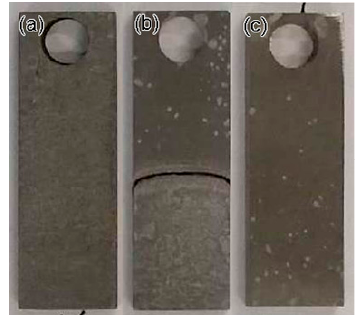
Figure 10. Morphology of specimens after removing corrosion products: ( a ) full immersion, ( b ) half immersion and ( c ) high-pressure gas exposure.